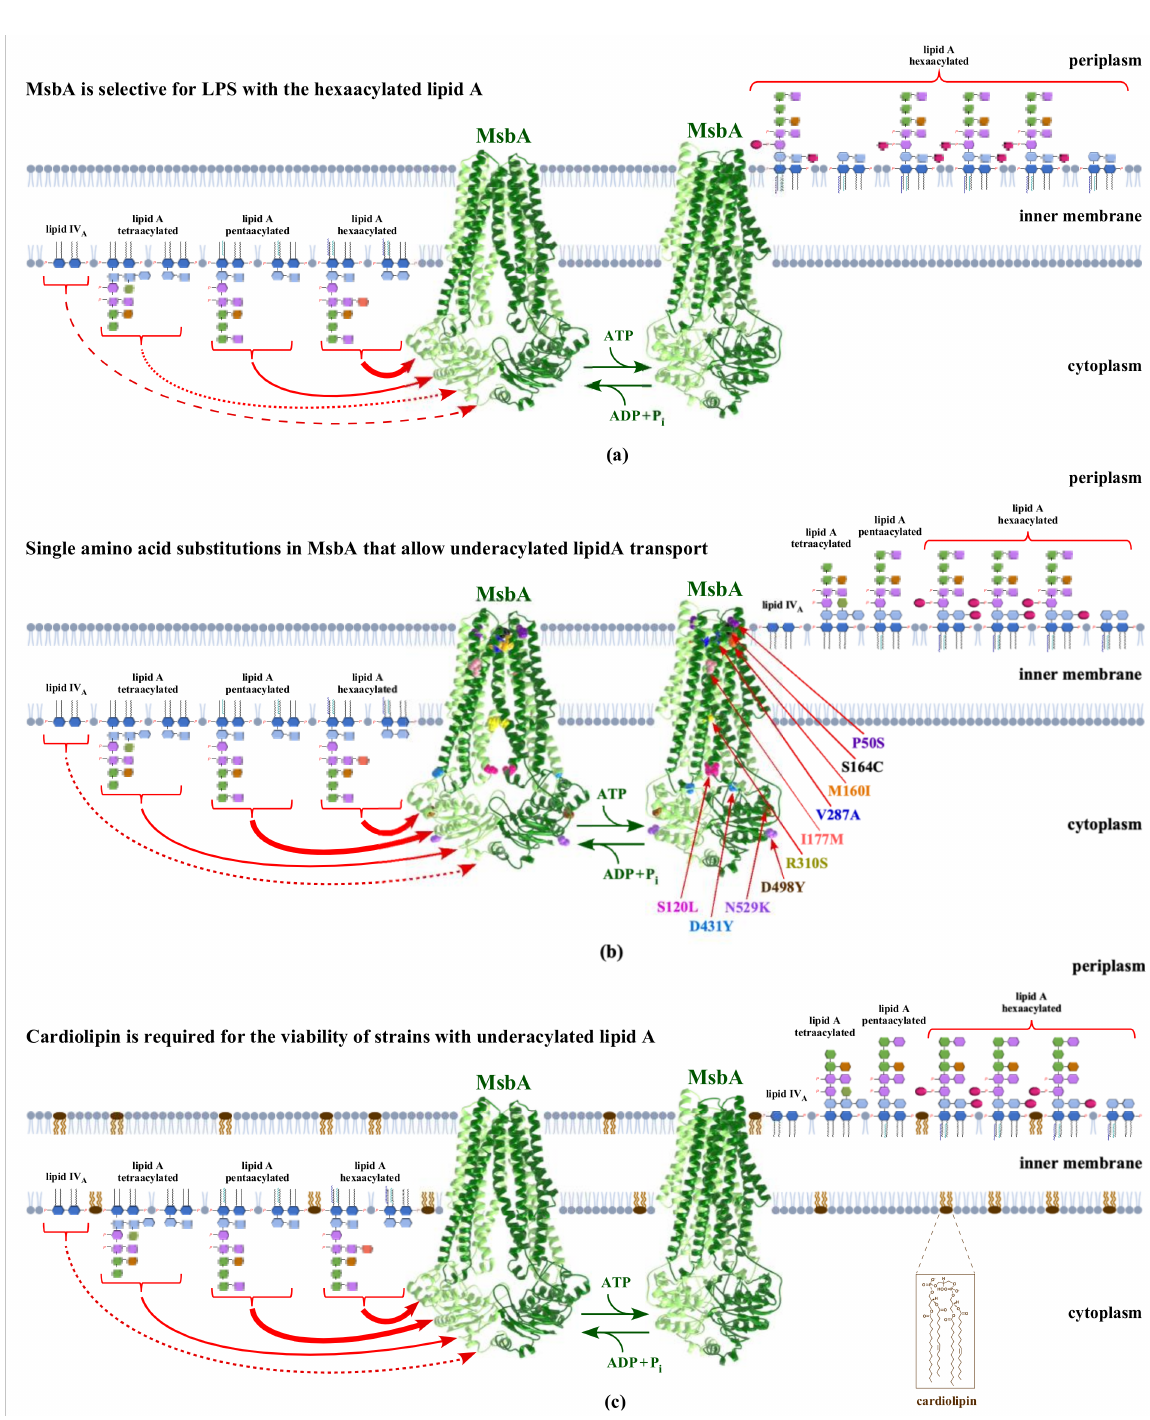
Figure 4. MsbA provides the crucial checkpoint by preferably selecting LPS with hexa-acylated lipid A. ( a ) MsbA has higher selectivity for hexa-acylated lipid A shown with a bold arrow. Selectivity for lipid IV A or tetraacylated lipid A is highly reduced, depicted as dashed and thinner arrows. ( b ) Single amino acid substitutions mapping to the lipid A-binding domain or in the LPS exit groove of MsbA that allows the translocation of tetra-acylated ∆ ( waaA ) or penta-acylated lipid A in ∆ ( clsA lpxM ) translocation due to relaxation in hydrocarbon ruler properties. ( c ) Absence of cardiolipin is lethal when E . coli synthesizes underacylated LPS, which can be overcome by mutations in the msbA gene. Bold arrows indicate higher selectivity for hexa-acylated as compared to thinner or dashed arrows for tetra-acylated species. Inset shows the presence of